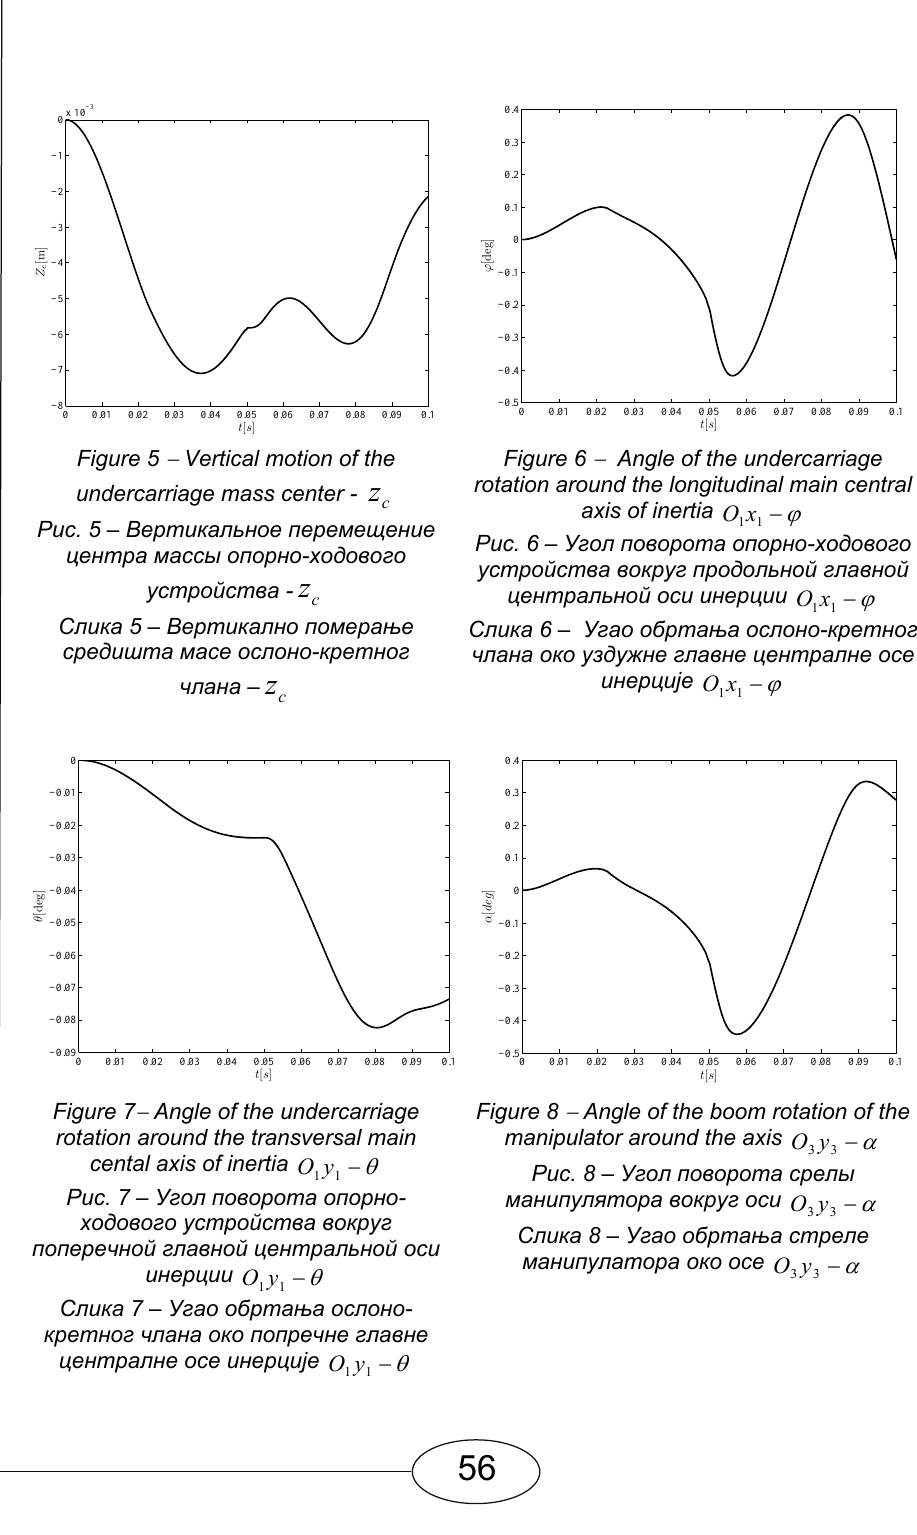
Figure 8  Angle of the boom rotation of the manipulator around the